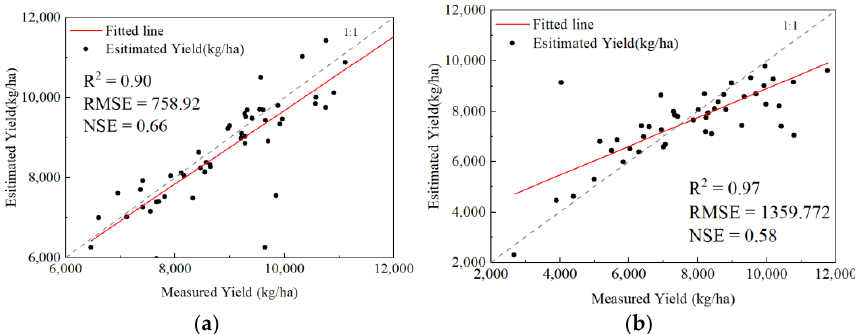
Figure 10. Crop yield. ( a ) Winter wheat; ( b ) Summer maize.